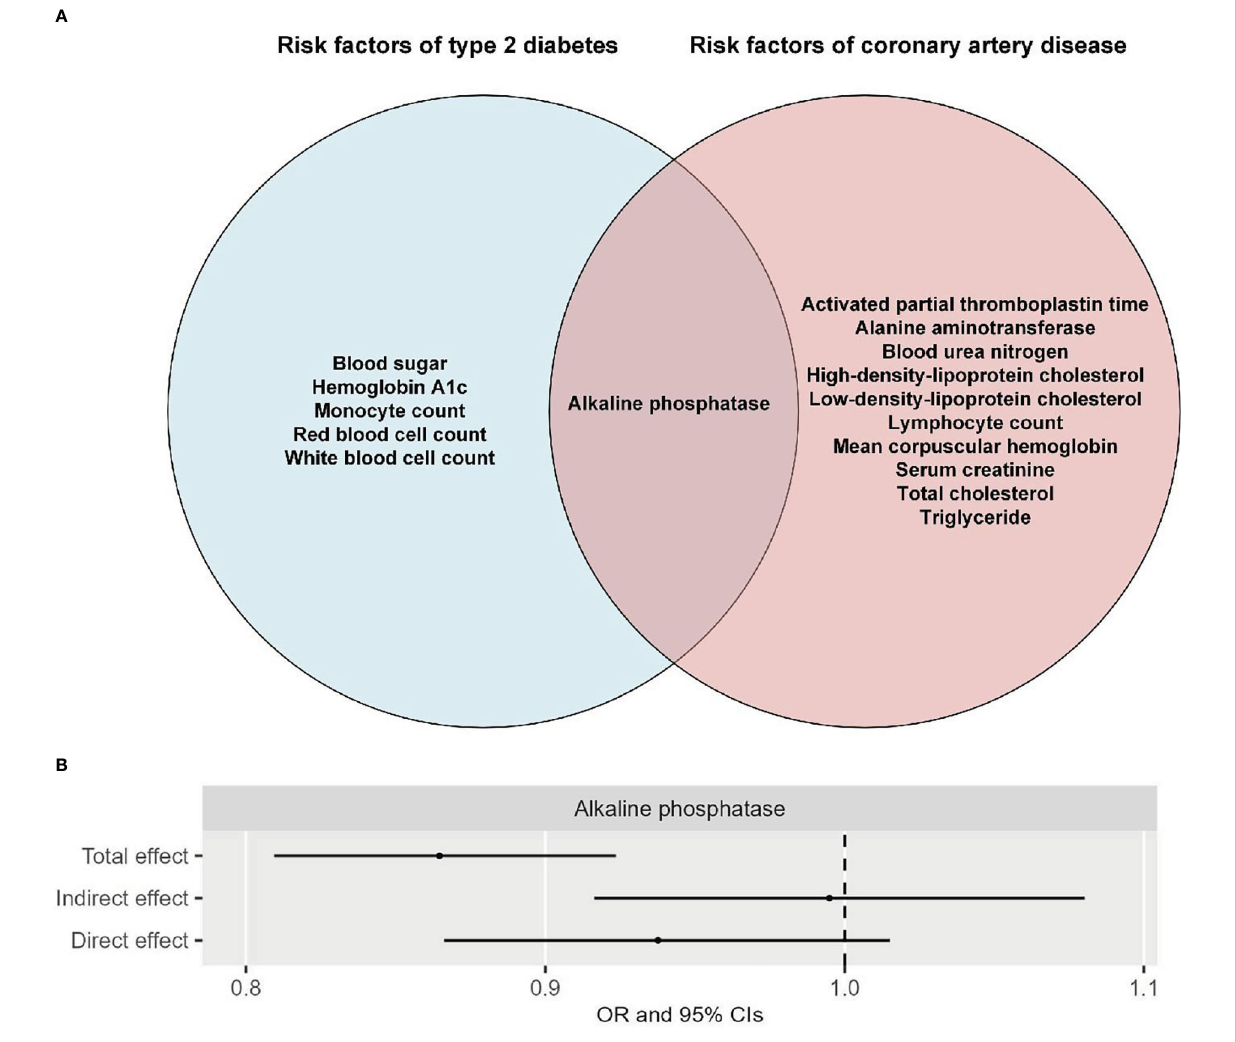
FIGURE 5 Shared and independent risks of T2D and CAD are presented in a Venn diagram (A) , and the total, indirect, and direct effects of alkaline phosphatase (ALP) on CAD are studied by causal mediation analyses (B) in the East Asian